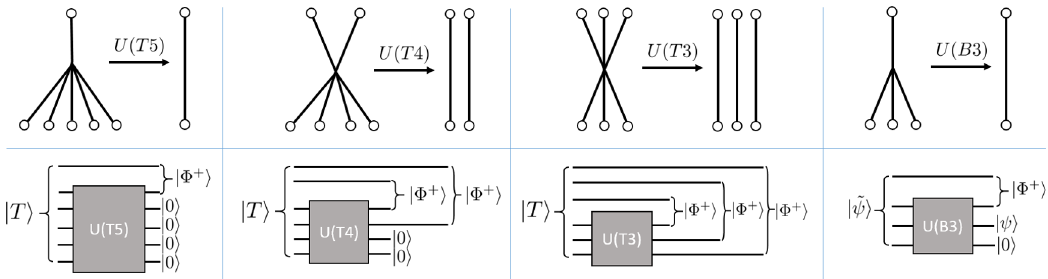
Figure 26. Local decoding/distillation procedure. We called the bottom degrees of freedoms as A in the main text. Top diagrams are transformations in the tensor network, where the local unitary acts on bottom degrees of freedom. The bottom diagrams are the corresponding circuit